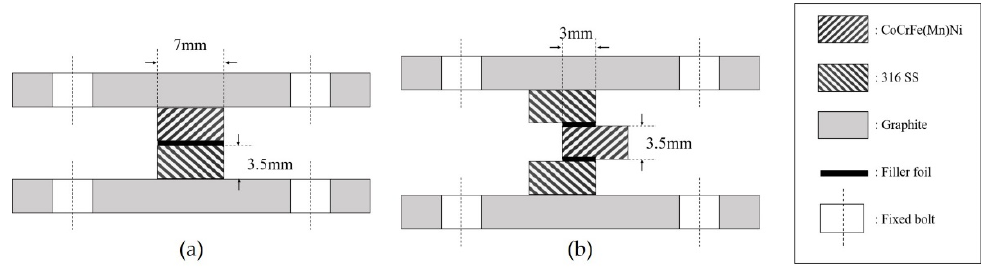
Figure 1. Illustrations of ( a ) microstructural observation and ( b ) shear test specimens.